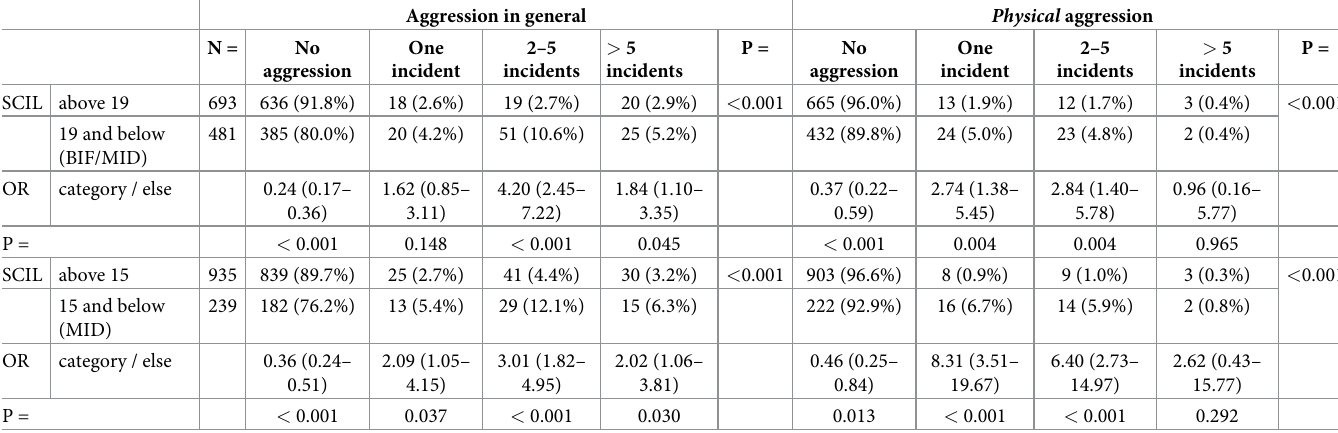
Table 1. BIF and MID compared to the number of aggression incidents.